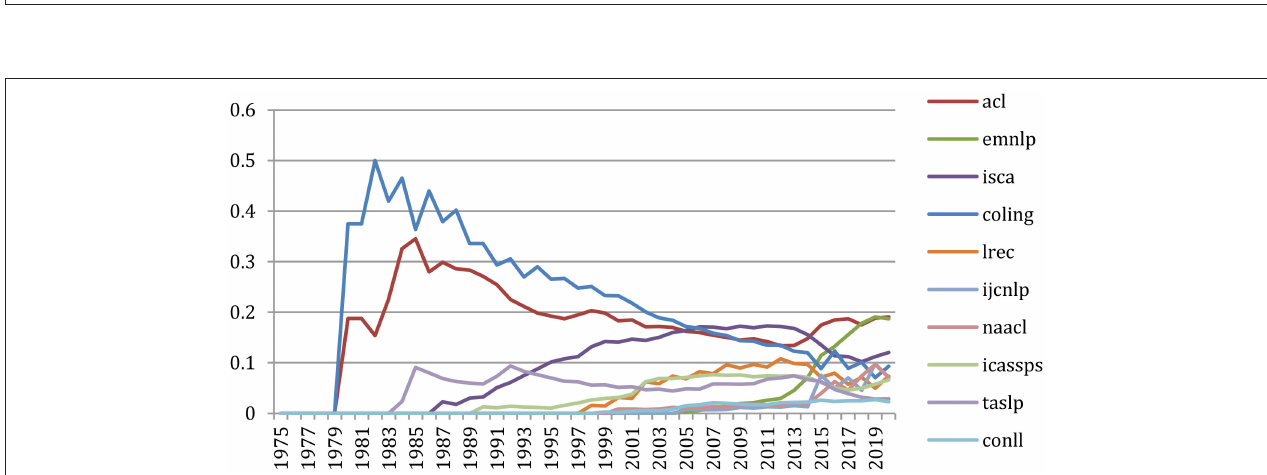
FIGURE 49 | Cumulative sources’ contributions to the study of “Embedding” in speech and NLP (% of topical papers).